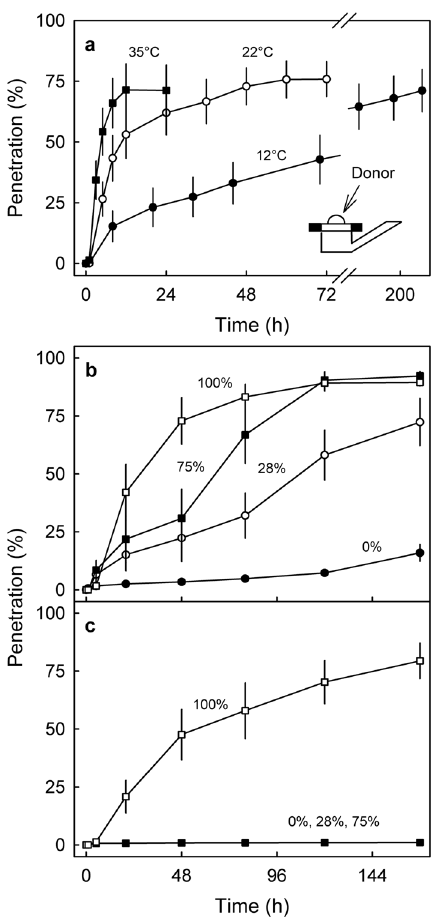
Figure 3. ( a ) Effect of temperature on the time course of penetration of 45 CaCl 2 through excised skin segments of mature sweet cherry fruit. Relative humidity (RH) was maintained constant at 75%. Inset: Sketch of a finite- dose diffusion cell. ( b , c ) Effect of RH on the time course of penetration of 45 CaCl 2 ( b ) or 45 Ca-formate ( c ). Temperature was maintained constant at 22 °C and RH was adjusted by holding diffusion cells above dry silica gel (0% RH), saturated CaCl